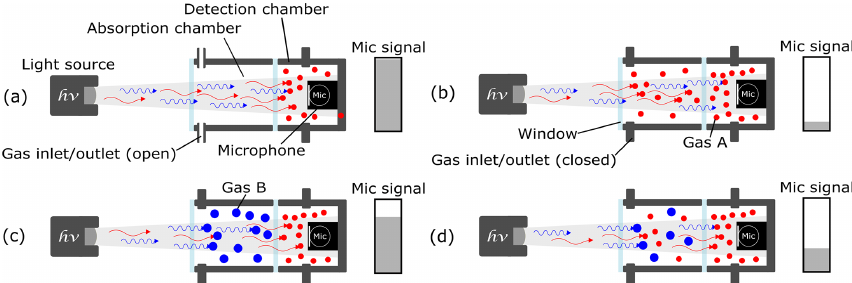
Figure 1. The working principle of a two-chamber-based photoacoustic detection. (a) An unfilled absorption chamber and a gas-filled detection chamber generate a maximum microphone signal amplitude. (b) When the target gas A is introduced into the absorption chamber, the microphone signal is reduced to its lowest value. (c) When an intruding gas B – which has similar IR absorption behavior (to gas A) – is filled into the absorption chamber, the microphone signal is slightly reduced due to cross sensitivities. (d) The detected signal of a gas mixture comprising gas A and gas B in the absorption chamber would include the additional signal of the intruding gas B.